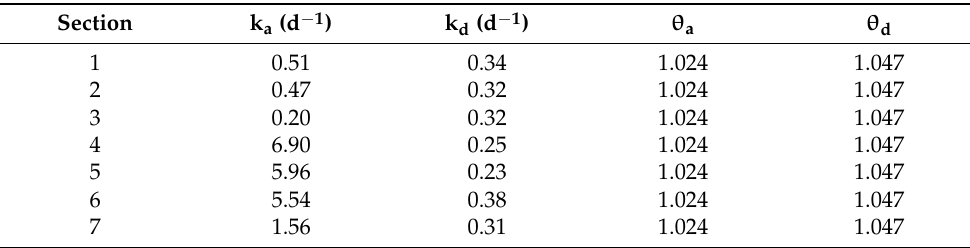
Table 2. Values obtained by calibration for the Reaeration Coefficient, Deoxygenation, and Tempera- ture Correction Factor that govern the system in the studied section of the Biob í o